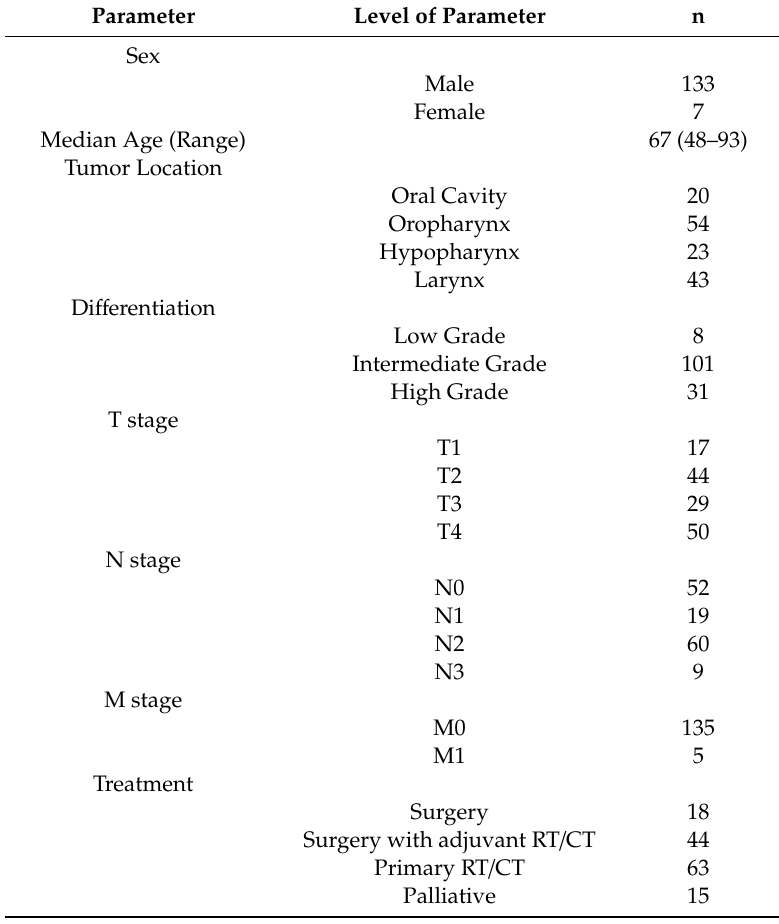
Table 1. Clinicopathological features of the selected patient group (TNM 7th edition was